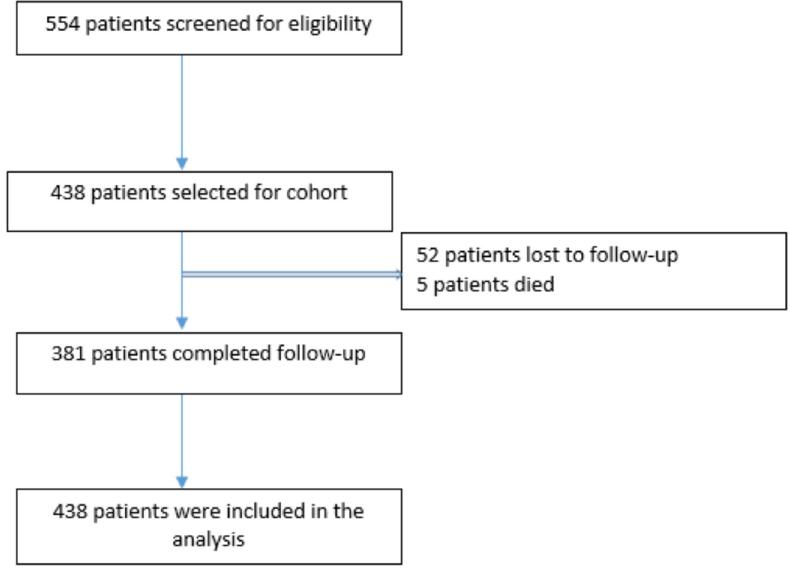
Fig 1. Sample selection in this prospective cohort study in adults with COVID-19